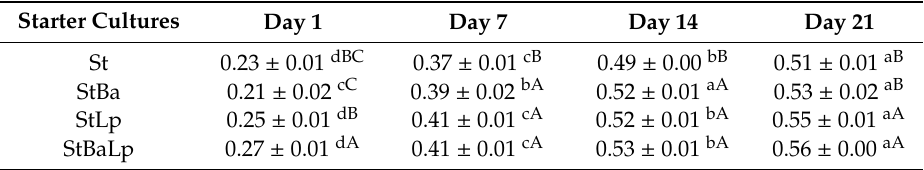
Table 2. The proteolytic activity (mmol / L) of the various combinations of starter cultures in fermented milk during 21-day storage at 4 ◦